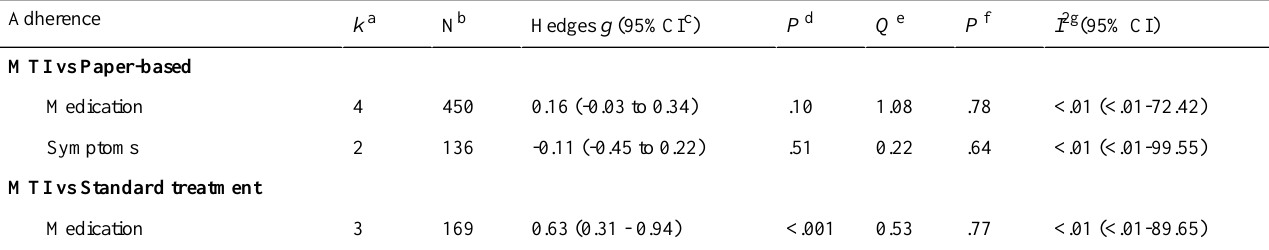
Table 4. Hedges g and tests of heterogeneity of mobile technology intervention (MTI) for